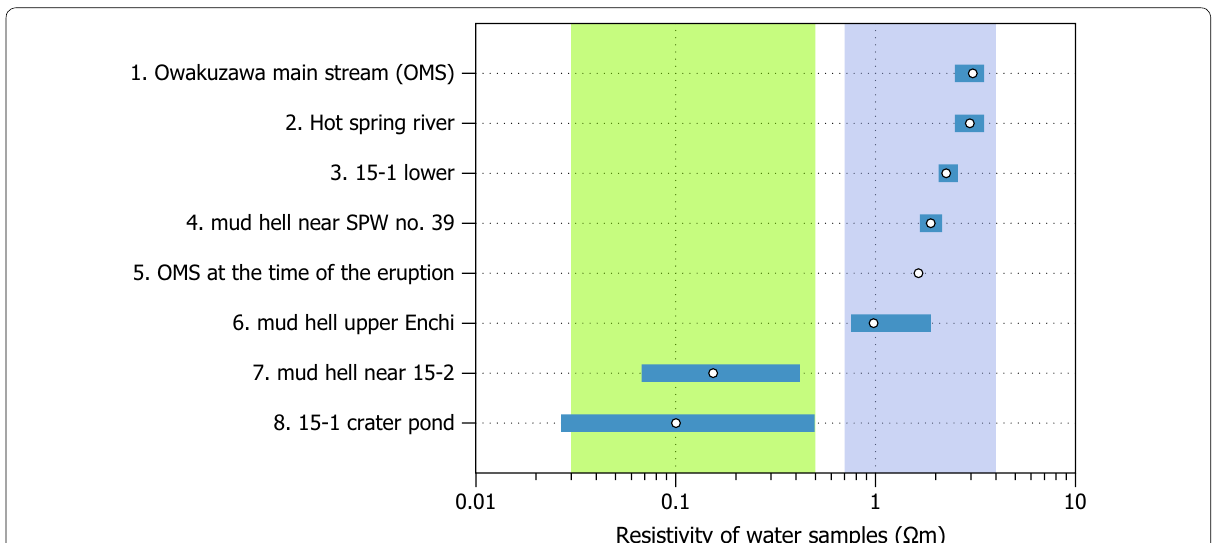
Fig. 4 Resistivity range of waters in Owakudani area. The sampling sites are represented in Fig. 2. The surface and mud hell waters suggest relatively higher resistivity (0.7–4 Ωm), whereas waters highly influenced by the new fumarole after the eruption demonstrate lower resistivity (0.03–5